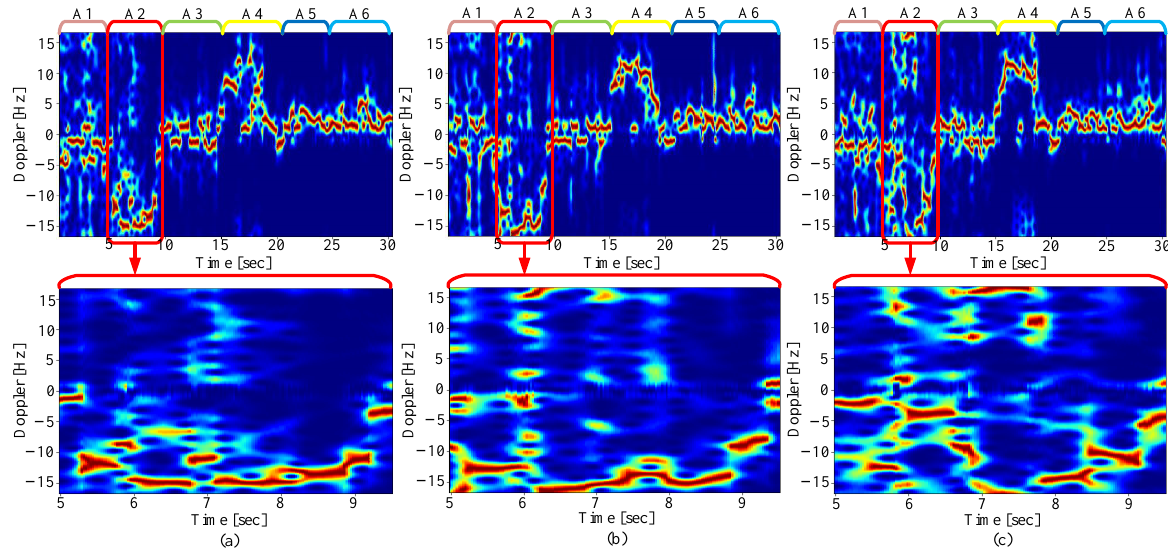
Figure 6. Spectrograms at ( a ) 1.7 GHz, ( b ) 1.9 GHz and ( c ) 2.1 GHz, where the top three sub-figures are global spectrograms of six continuous activities and the bottom three sub-figures are partially zoomed spectrograms of single activity